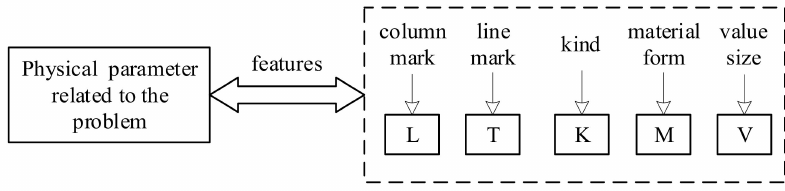
Figure 4. Features of the physical parameter.